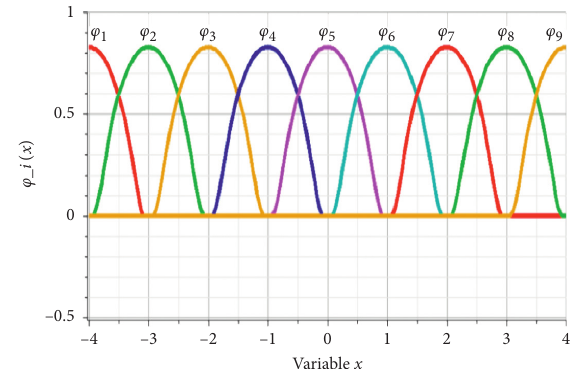
Figure 1: Illustration of the elements of the family ( φ